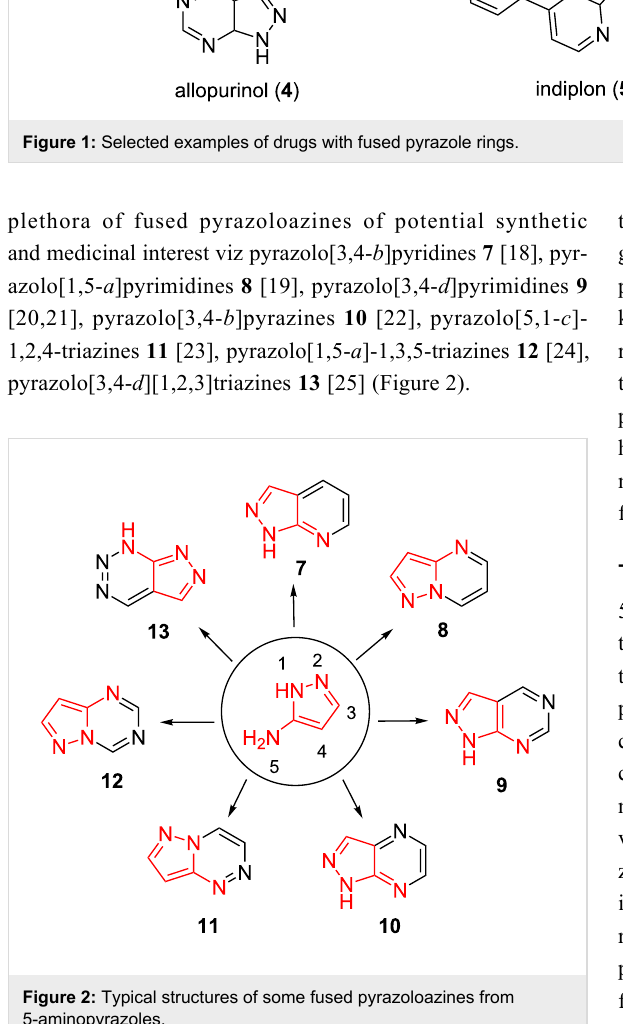
A number of review articles have been published by us and others highlighting the synthetic and biological aspects of 5-aminopyrazoles [26-28] as well as on the synthesis of fused pyrazole derivatives [25]. However, a perusal of literature reveals that the importance of 5-aminopyrazoles as synthetic precursors for fused heterocycles has not been reported till